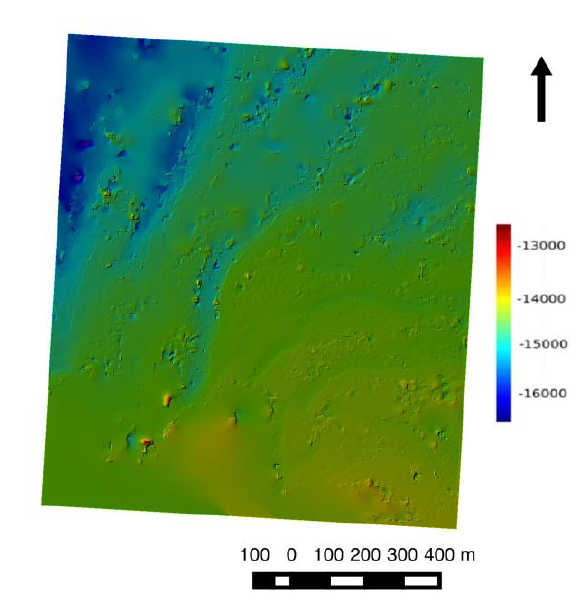
Figure 4. Colourised hillshade image of DTMs: (a) H2162_0000 with the DLR-VICAR method. (b) Kim & Muller can be seen in Figure